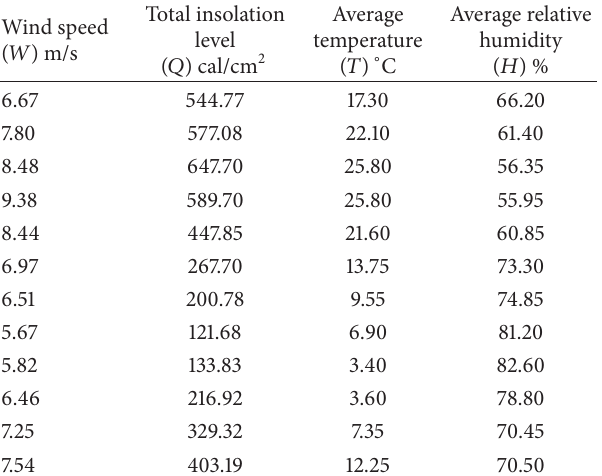
Table 1: The monthly average meteorological parameters from May 2010 to April 2012.